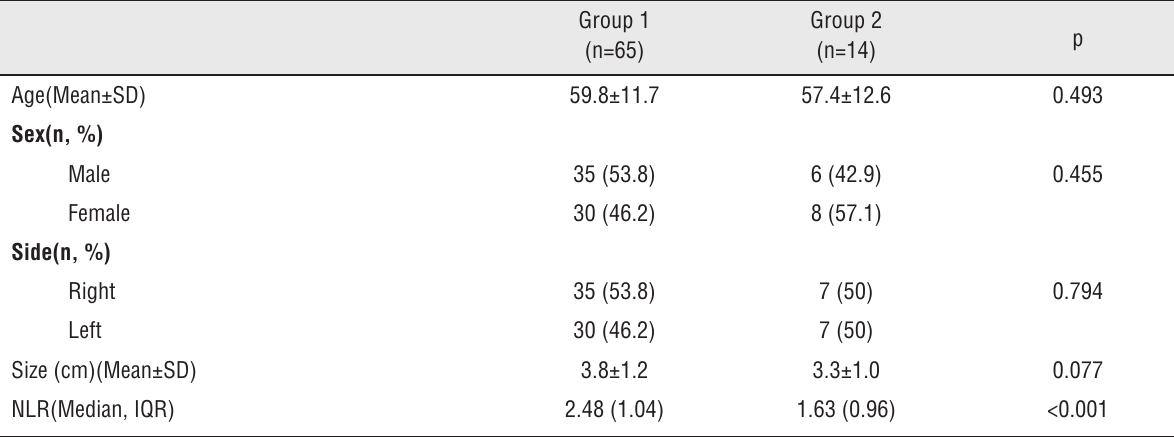
Table 1 - Descriptive characteristics of the patients.